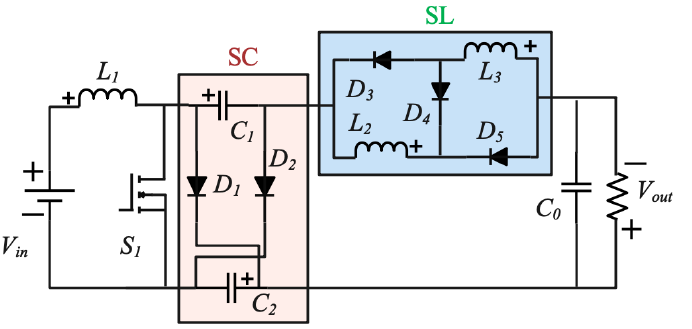
Topology 2: Power circuit of type-2 switched-inductor-switched-capacitor (SLSC) Cuk